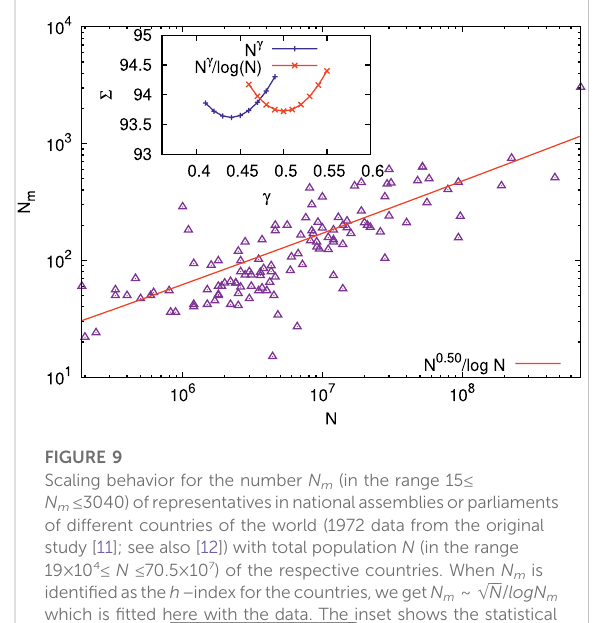
(cid:1)(cid:1) √ N p /log N p in Figure